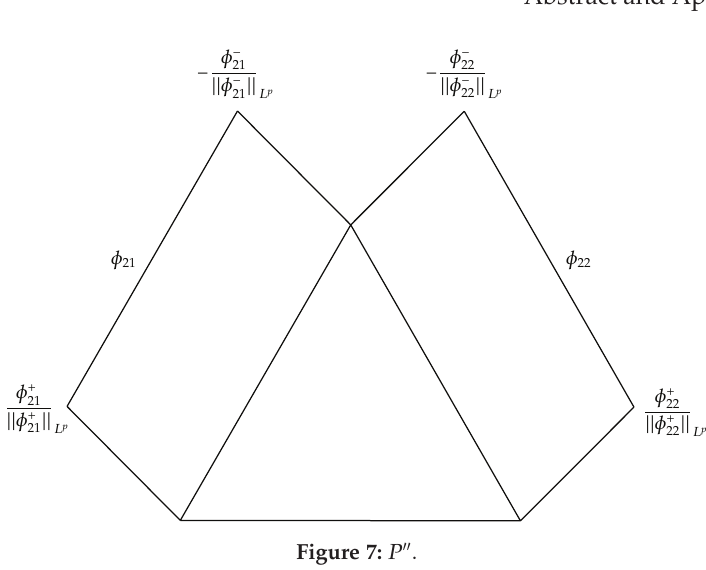
Figure 7: P (cid:2)(cid:2)